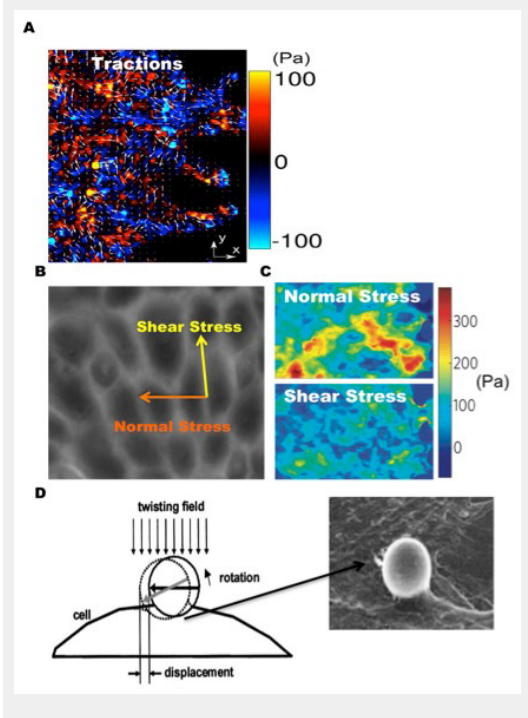
Cell mechanics methodologies. (A) Colour-coded map of traction force (x-component) overlaid with arrows depicting complete traction vector (x and y component) of migrating monolayer using traction force microscopy. (B) Utilising monolayer stress microscopy we are now able to determine the normal and shear intercellular stress components within a monolayer of cells and (C) observe their corresponding spatial distributions. Cells within a monolayer are generally observed to have a rugged stress landscape and be mainly in tension. (D) OMTC is yet another useful technique used to probe cell material properties by attaching a ligand-coated magnetic bead to cell surface receptors and applying a torque to the bead with an external magnetic field. Adapted with permission from Tambe et al. Nat Mater. 2011;10(6):469–7 [14] and Fabry et al. Phys Rev E Stat Nonlin Soft Matter Phys. 2003;68(4Pt1):041914